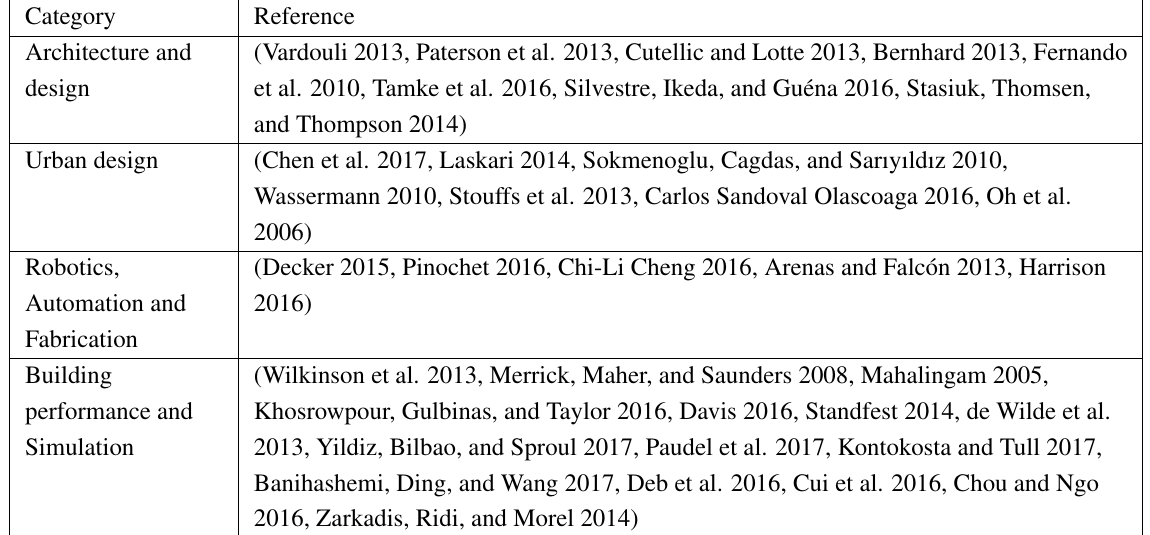
Table 1. Review of recent architecture-and-design-basedMachine Learning